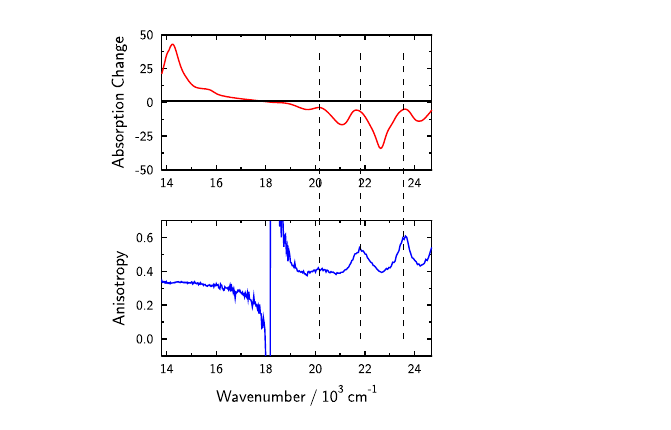
Figure 2: Transient absorption of perylene in acetonitrile at 500fs after photoexcitation at magic angle (upper panel), transient anisotropy at the same configuration (lower